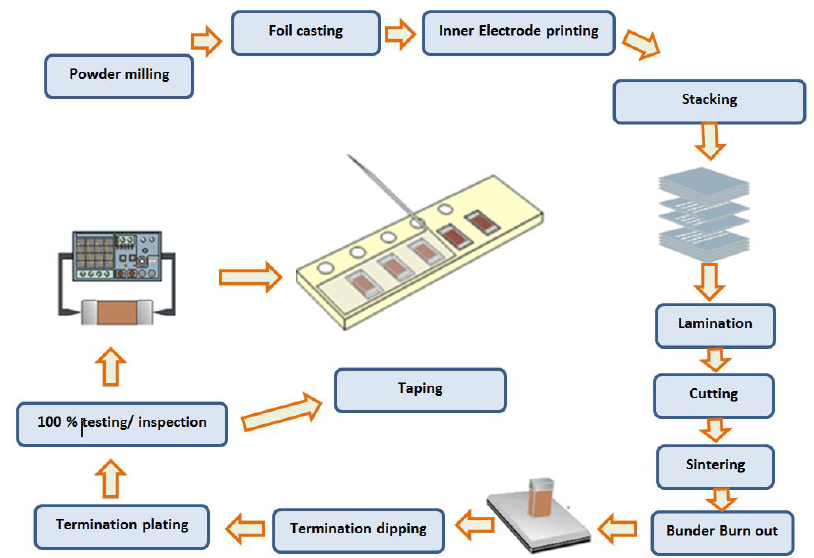
Figure 6. MLCC architecture and fabrication process schematics.